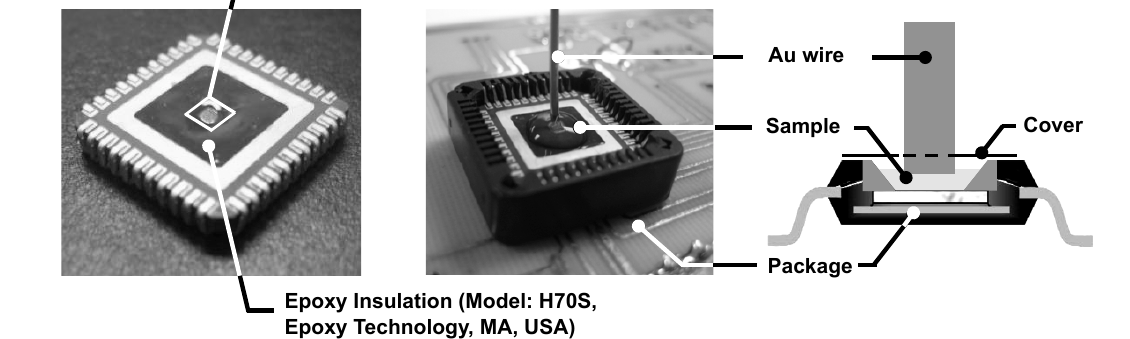
Figure 12. Packaging and electrochemical experimental setup.